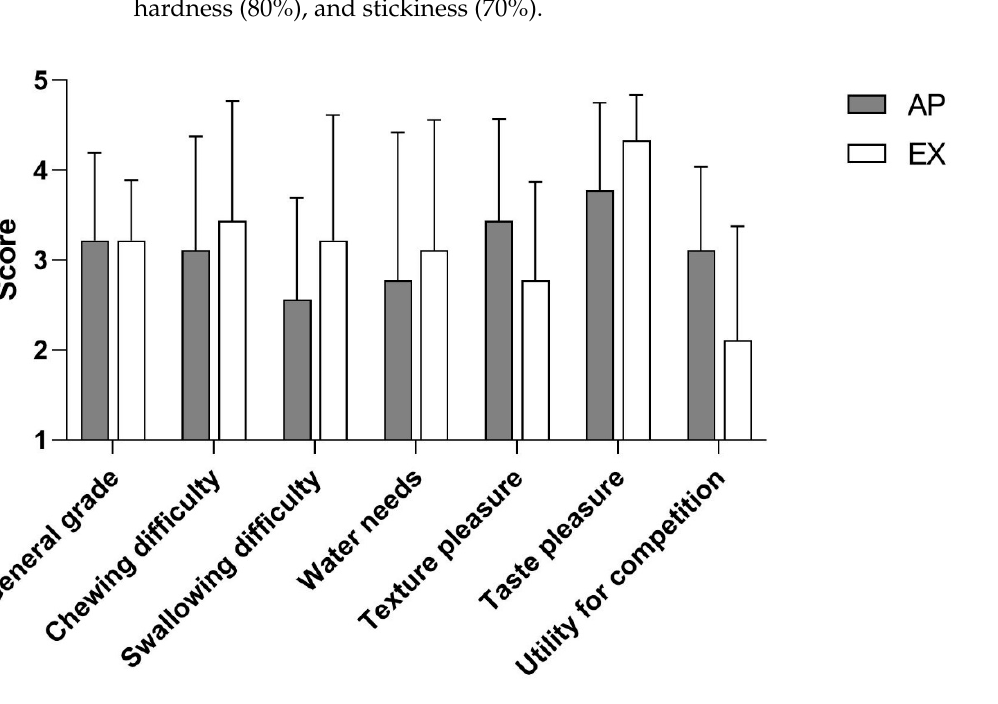
Figure 3. Results of the satisfaction perception survey scored from 1 (“very bad/a little”) to 5 (“very good/a lot”). Abbreviations: AP, Aptonia bar, EX, Etixx bar. No significant differences were